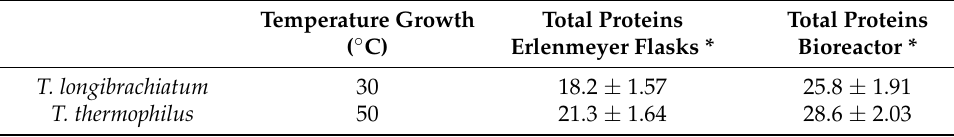
Table 5. Comparison between production in Erlenmeyer flasks and